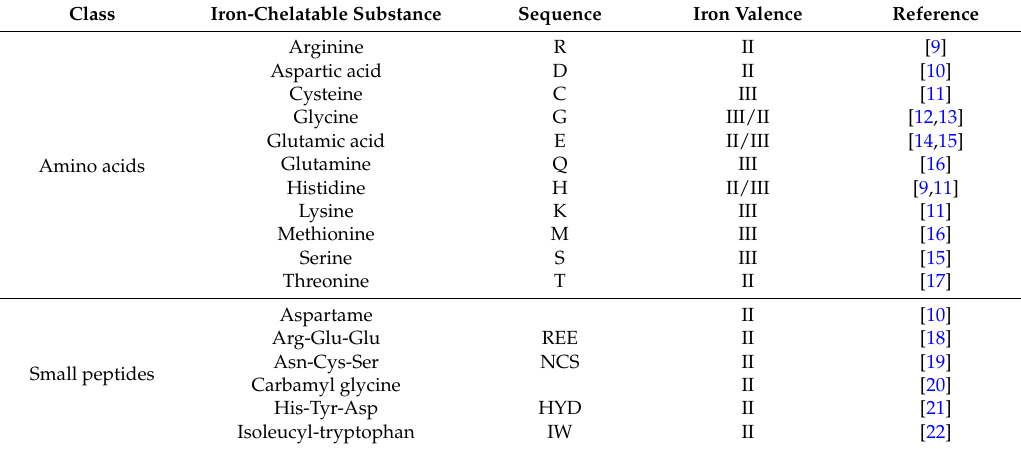
Table 1. Iron-chelatable amino acids, peptides and